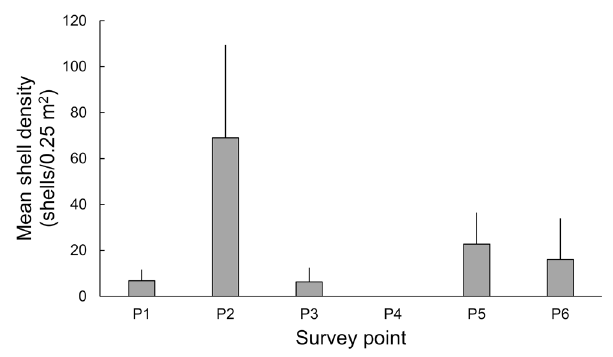
Figure 5. Mean number of empty gastropod shells in four quadrats (50 × 50 cm each) established along the intertidal zones at the survey points (P1–P6). Vertical bars indicate the standard deviations.